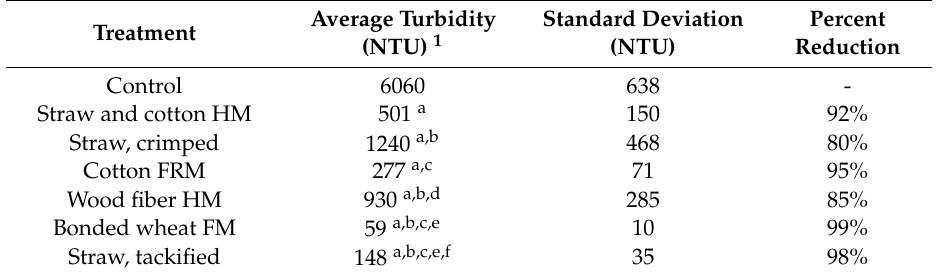
Table 4. Average turbidity, standard deviation, and percent reduction of each treatment with respect to the control of four 15-min events for surface runo ff .